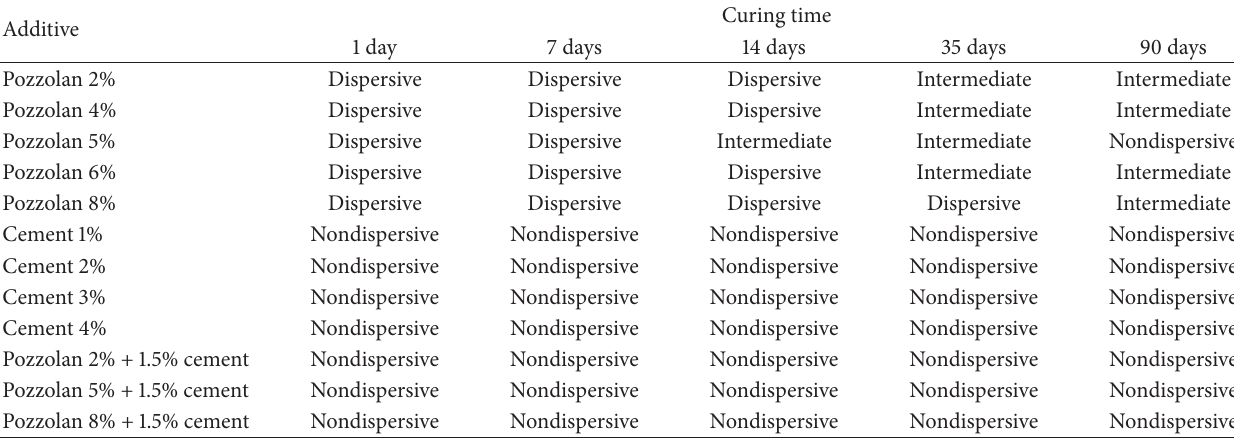
Table2:Categorizationbasedondoublehydrometertestresultsofclaysamplestabilizedwithpozzolan,cement,andpozzolanplus1.5percent cement.